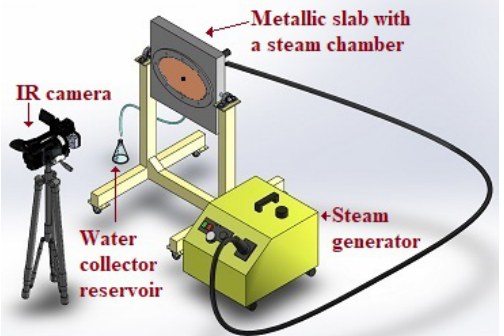
Figure 3. Experimental setup for the real-time observation of steam injection into a steam chamber enclosed in a metallic slab. The IR camera allowed us to observe the time evolution of the temperature field in the steam